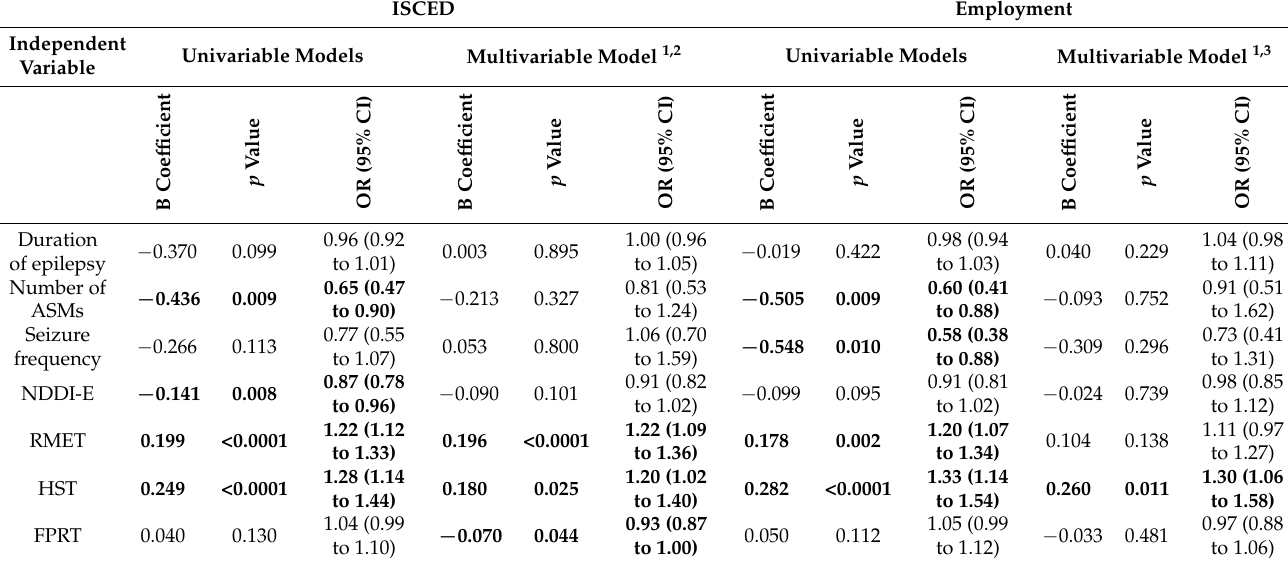
Figure 2. Correlations between the level of education, ToM and ER tasks and the measure of quality of life. *— p < 0.05, **— p < 0.0001. FPRT—faux pas recognition test (total score), HST—the Happé strange stories test, ISCED—The International Standard Classification of Education, RMET—Reading of the Mind in the Eyes test, QOLIE-31—The 31-item Quality of Life in Epilepsy inventory (total score). Table 3. Regression analysis for real-life outcomes represented by the level of achieved education, according to the ISCED scale, and the binary fact of being employed at the moment of cognitive testing (variables with p < 0.05 are bold), 1 — missing n = 3 (3.7%), 2 — χ 2 = 34.697, p < 0.0001, 3 — χ 2 = 21.148, p = 0.004, constant B = − 3.105, p = 0.149, OR = 0.45 (95% CI =